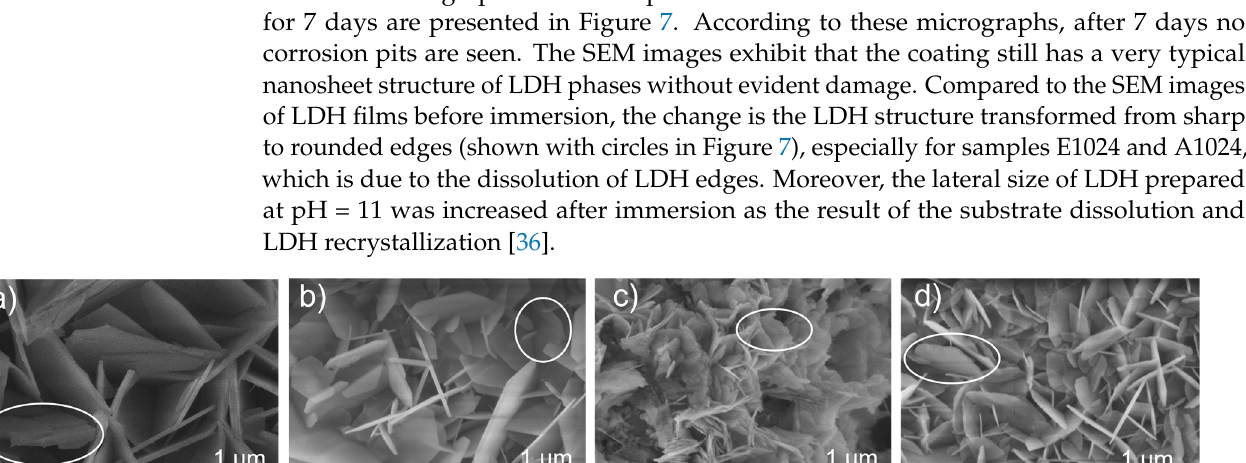
Figure 6. SEM images of ( a ) E1024, ( b ) E1124, ( c ) A1024, ( d ) A1124, before applying the tape and ( e ) E1024, ( f ) E1124, ( g ) A1024, ( h ) A1124 after peeling off. 3.2. Physical and Chemical Characteristics of LDH After Immersion in 0.1 M NaCl for 7 Days.